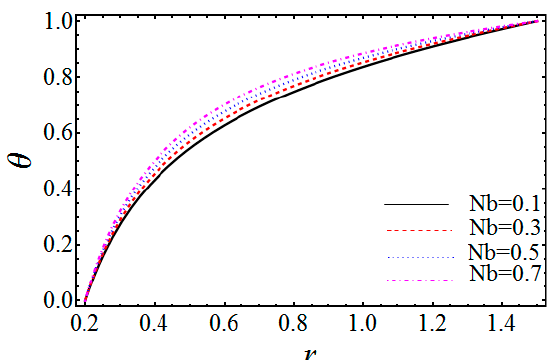
Figure 9. Variation of temperature profile θ with Nb for fixed θ = 0.1, ϕ = 0.5, δ = 0.1, ε = 0.1, V = 0.3, λ 1 = 0.7, z = 0, t = 0.3, Nt = 0.2, Br = 0.5.